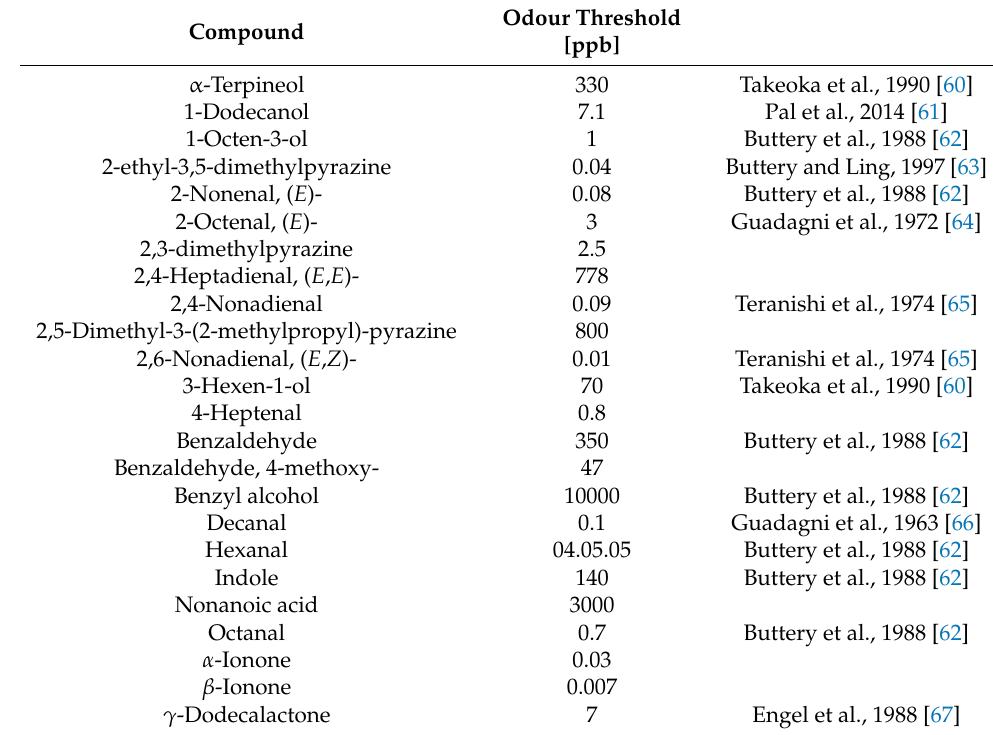
Figure A4. MS spectra of the identified substances (red beams) and the corresponding substance of the NIST Mass Spectral Library (blue beams). Table A14. Chemical compounds and their associated odour thresholds.